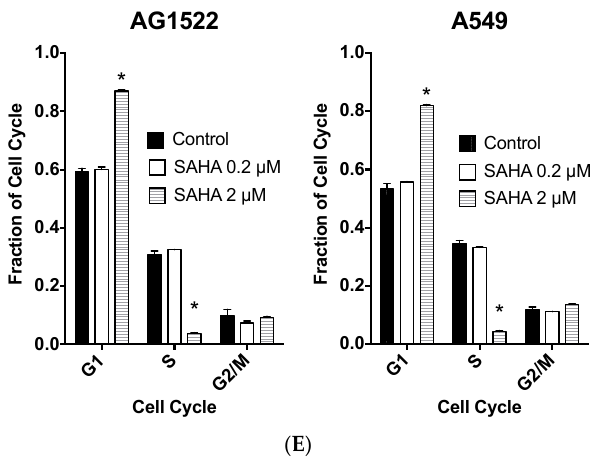
Figure 1. Suberoylanilide hydroxamic acid (SAHA)’s effects to human normal fibroblast and cancer cell culture conditions. ( A ) Cellular doubling times of AG1522 and A549; ( B ) Cellular toxicity evaluated by cell growth for three days in the presence SAHA; ( C ) Cellular toxicity evaluated by clonogenic ability as plating efficiency; ( D ) Flow cytometry profiles after SAHA treatment for 24 h; and ( E ) Cell cycle distribution after 24 h SAHA treatment. Error bars indicate standard error of the means. * marks mean statistically significant differences compared to control ( p < 0.05). All least three times independently.